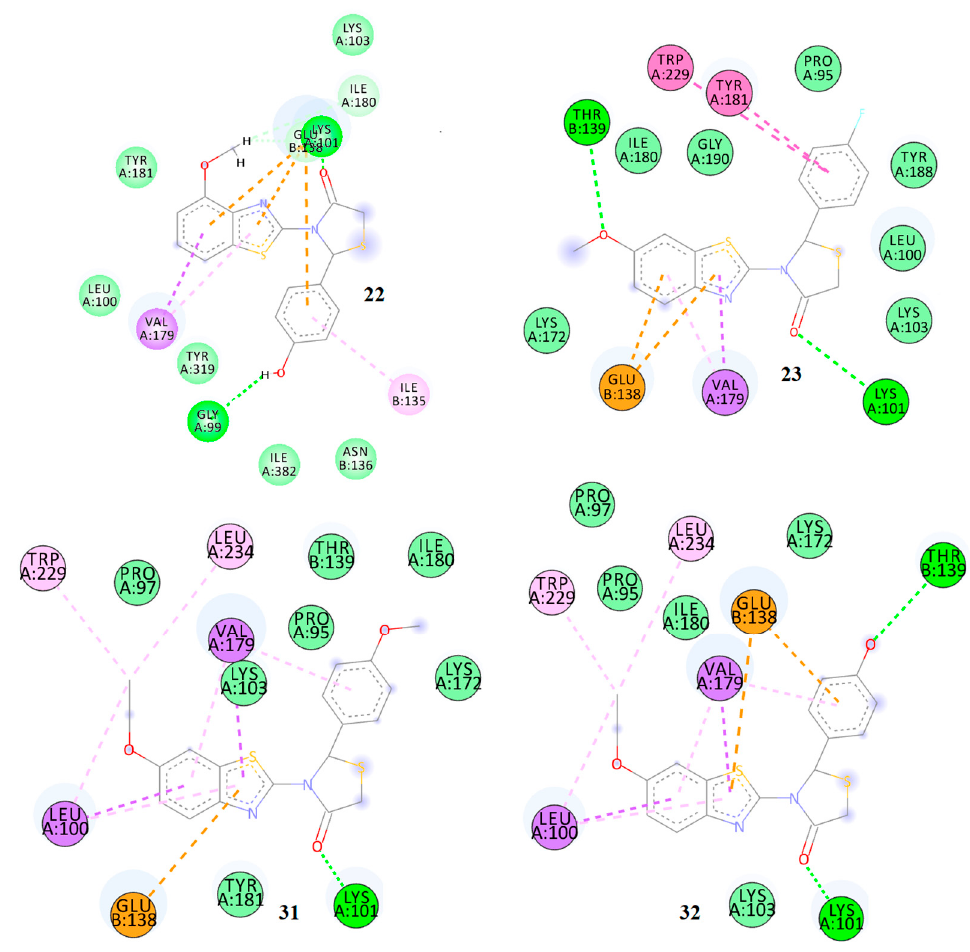
Figure 9. 2D docking diagrams of compounds 19, 20, 27, and 28 at the allosteric site of HIV-1 RT.